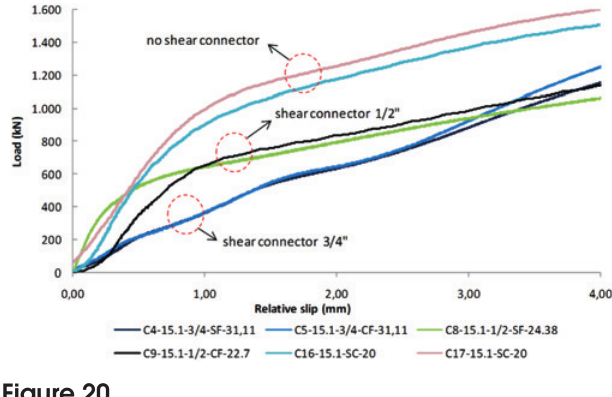
Figure 19 Comparison between the curves load versus displacement relative to the tube 219x8,2 of series A and B